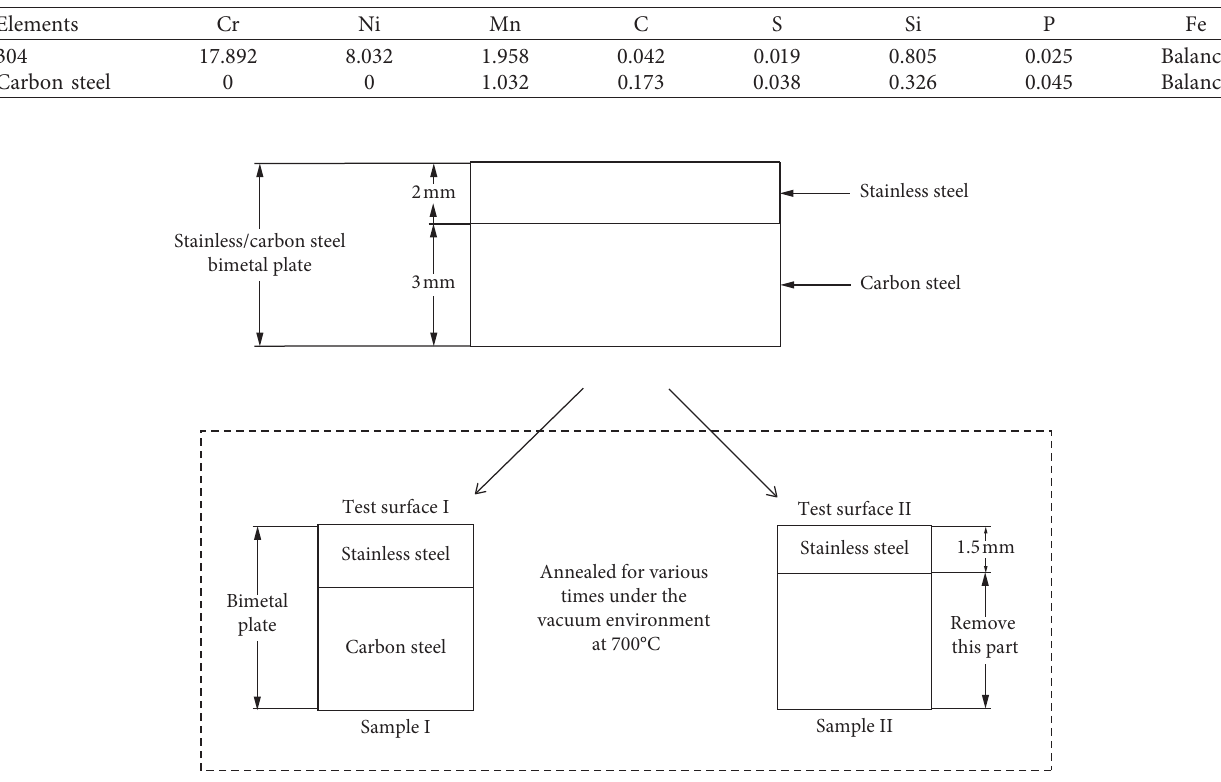
Figure 1: Sampling schematic diagram for Sample I and Sample II.